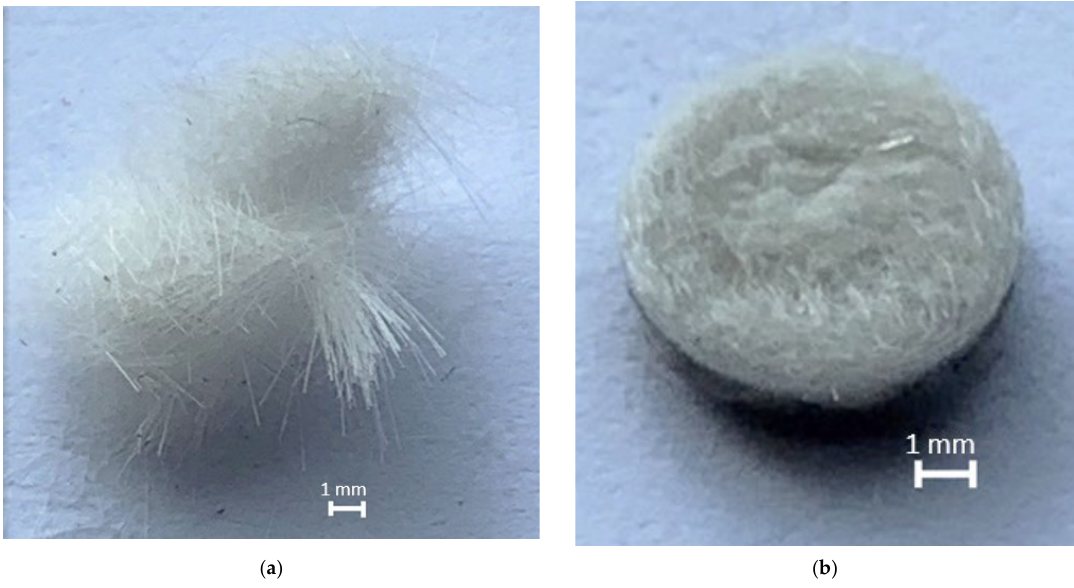
Figure 7. PCS test sample before ( a ) and after ( b ) thermomechanical analysis at up to 400 ° C. Analysis of the PCS sample microstructure after TMA shows clearly visible insular buildups on the fiber surface (Figure 8), while in the initial state the fiber surface was free of them.